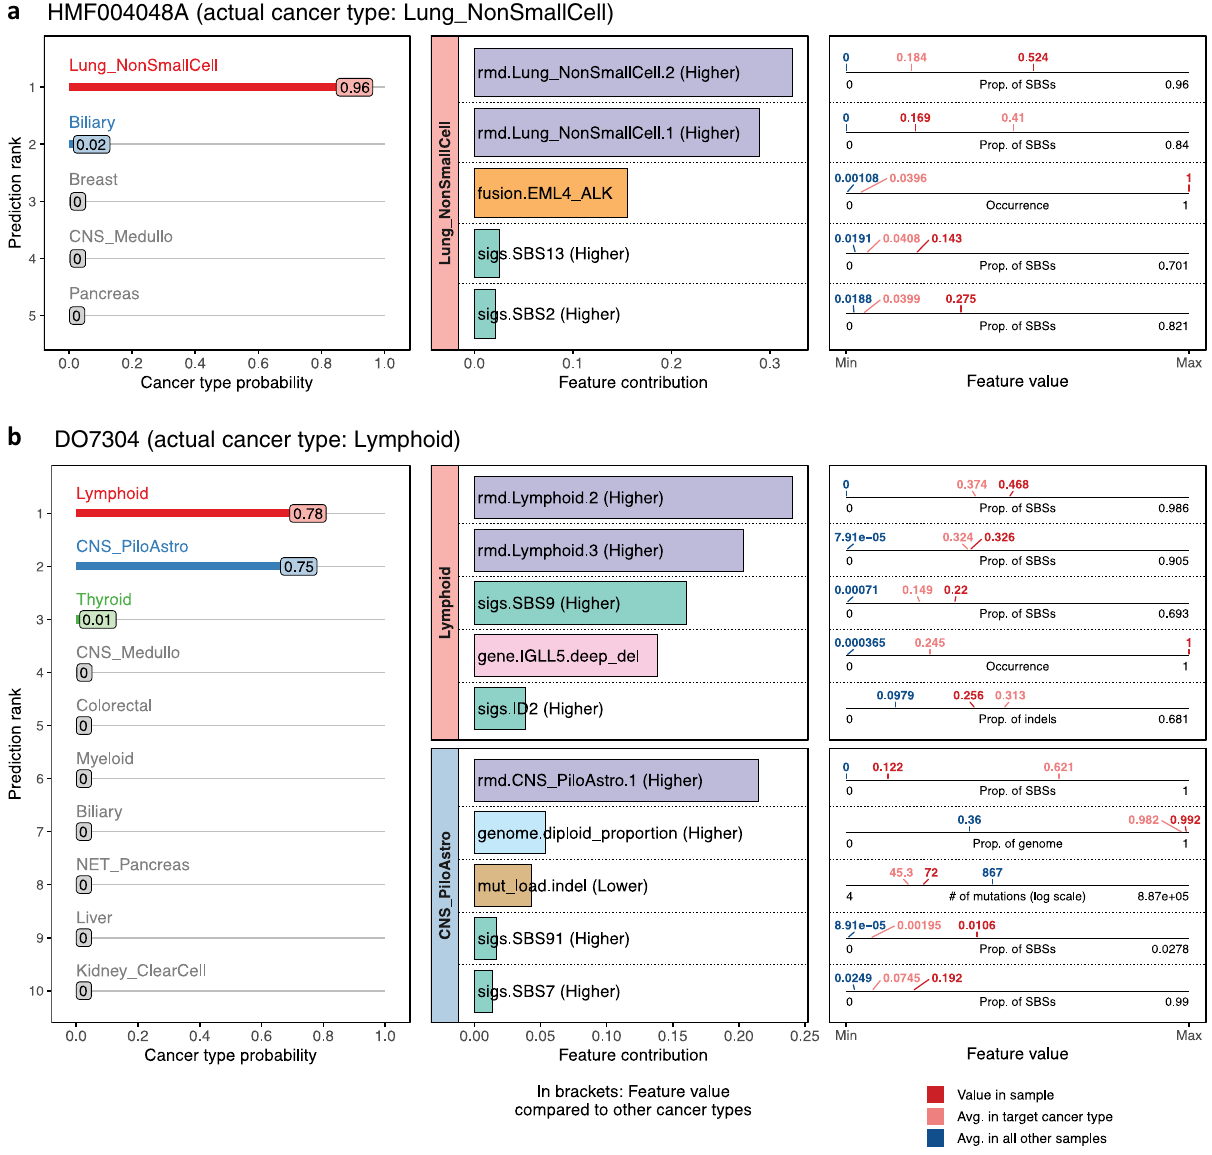
Fig. 4 Graphical report for CUPLR predictions. Example reports are shown for two patients from the holdout set: a HMF004048A, annotated as having non-small cell lung cancer (Lung_NonSmallCell), and b DO7304, annotated as having lymphoma (Lymphoid). The leftmost panels show the predicted cancer type probabilities. In the middle panels, contributions of the top features are shown for the top predicted cancer types. When there is uncertainty in the cancer type probabilities such as in b , more feature contribution panel rows are shown. In the rightmost panel, the feature values in the patient (red label) are plotted in relation to the average feature value amongst patients in the training set with the target cancer type (pink label) as well as all other samples not belonging to the target cancer type (blue label). For a full description of each feature, see Supplementary data 3. Feature type abbreviations: rmd regional mutation density pro fi le, sigs mutational signatures, mut_load total number of single base substitutions, double base substitutions or indels, gene presence of gene gain or loss of function events, genome genome properties including genome ploidy, diploid proportion, whole-genome duplication status, fusion presence of gene